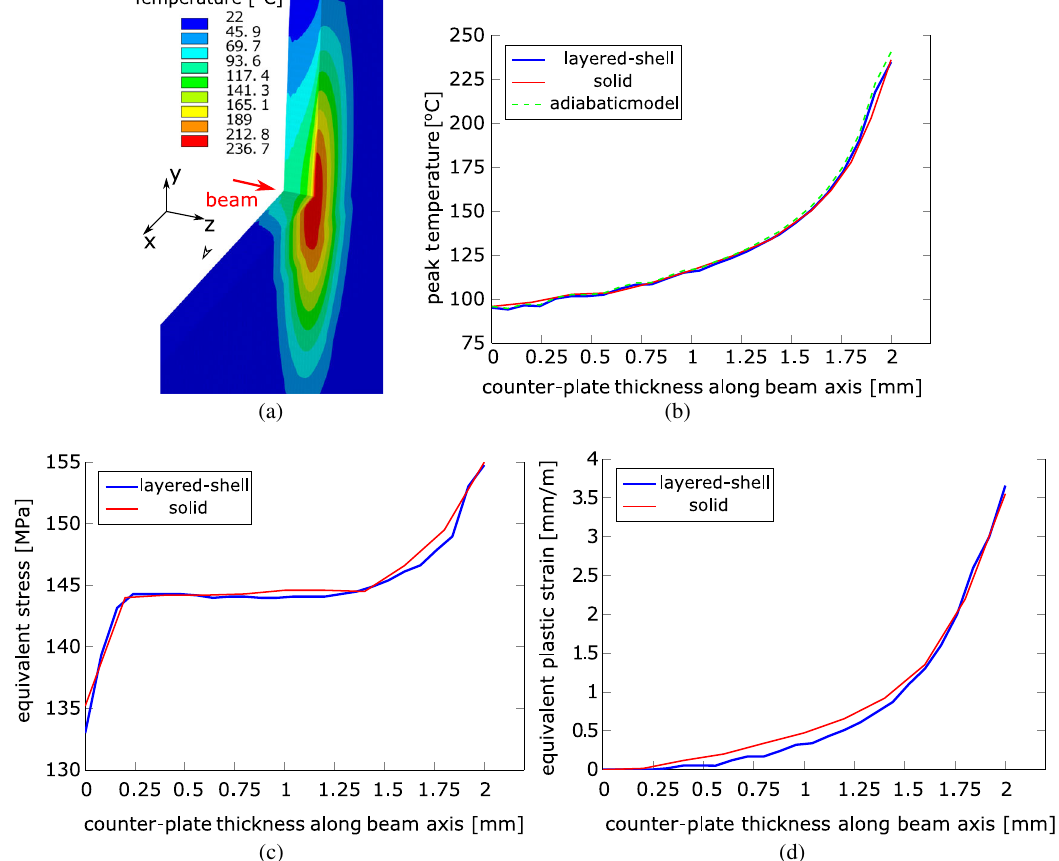
FIG. 4. (a) Through-thickness temperature distribution in the counterplate at the end of one beam pulse. (b) Peak temperature along the beam axis using a layered-shell model and a solid-element model. (c) Through-thickness equivalent stress and (d) equivalent plastic strain along the beam